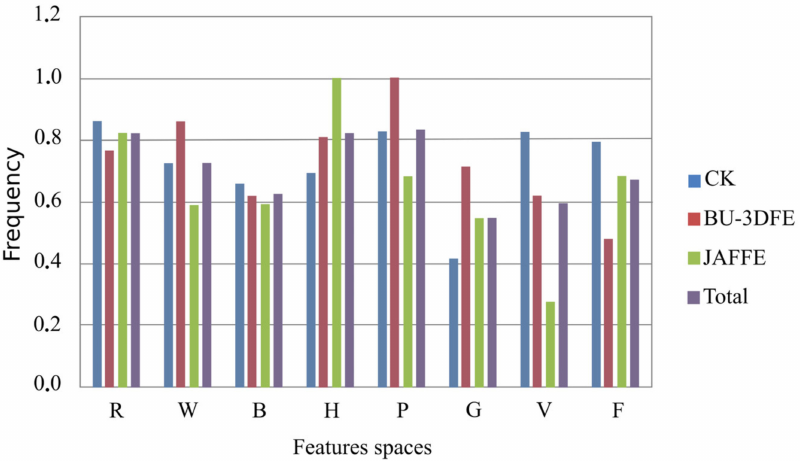
Figure 6. Frequency of features in selected combinations (Tables 3–5) for the CK+, BU-3DFE, and JAFFE data sets. RAW: (R), GW: (W), LBP: (B), HOG: (H), LPQ: (P), GEO: (G), VGG: (V), VGGF: